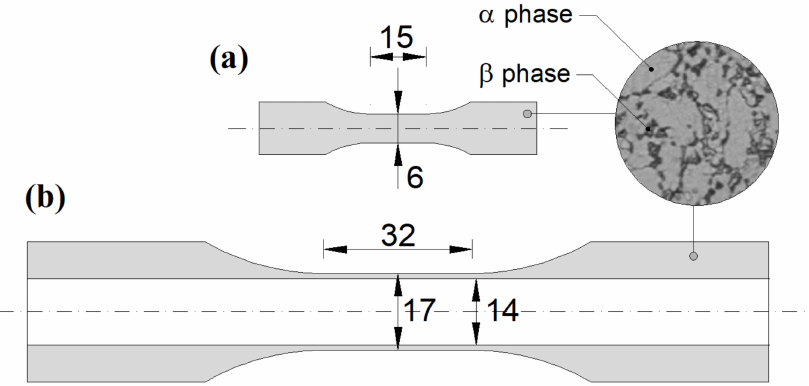
Figure 1. Specimens employed for ( a ) axial fatigue tests and ( b ) torsional and combined ax- ial/torsional tests. The material microstructure is also reported: alpha grains (light) with intergranular beta phase